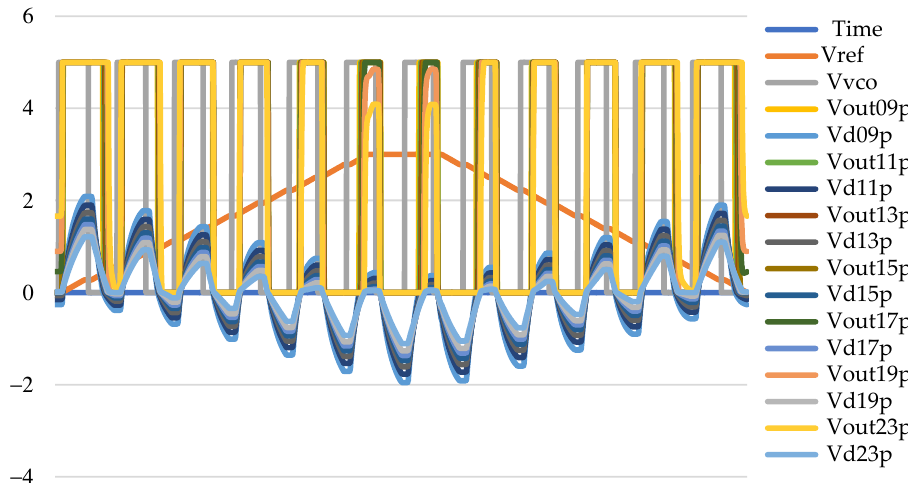
Figure 18. Influence of the capacitance C cm on the VFPWM output.